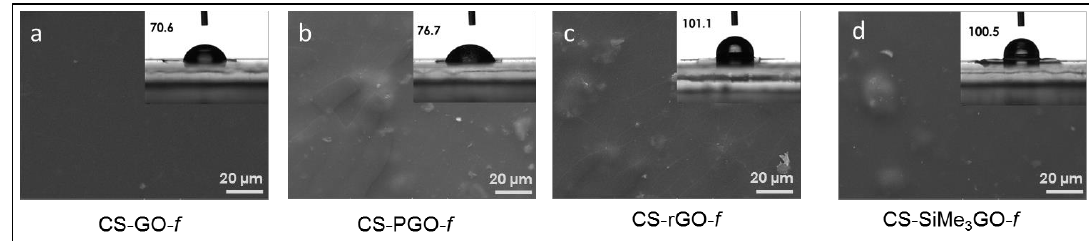
Figure 3. SEM analyses and contact angle measurement (onset) of: CS-GO- f ( a ), CS-PGO- f ( b ), CS-rGO- f ( c ), and CS-SiMe3GO -f ( d ).